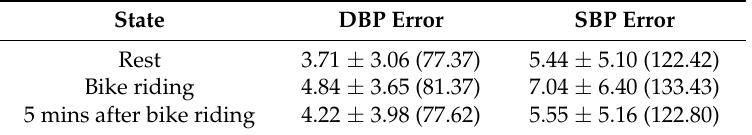
Table 1. Averages and errors of the estimated BPs.